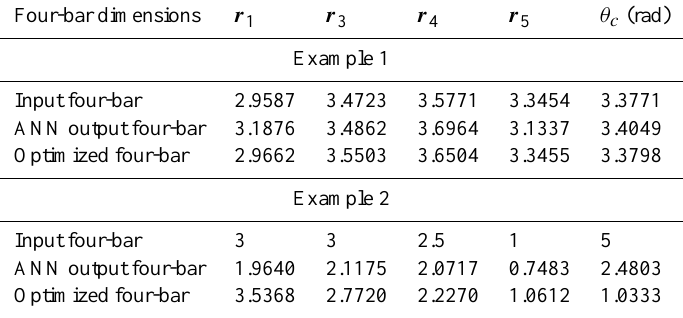
Table 2. Results for examples 1 and